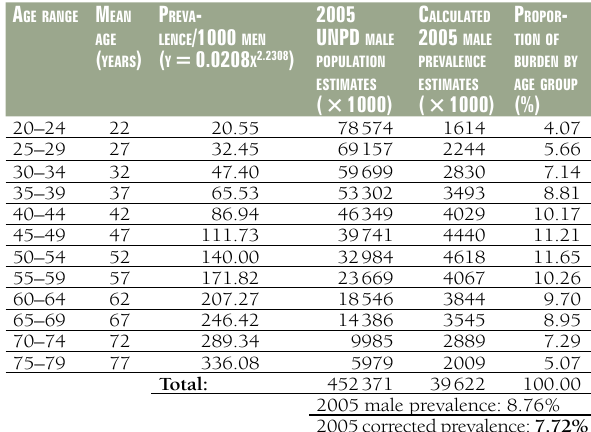
Figure 5. Relationship between crude prevalence of type 2 diabetes and age in Southern Asia in male examinees. Table 13. Male prevalence estimates for 2005